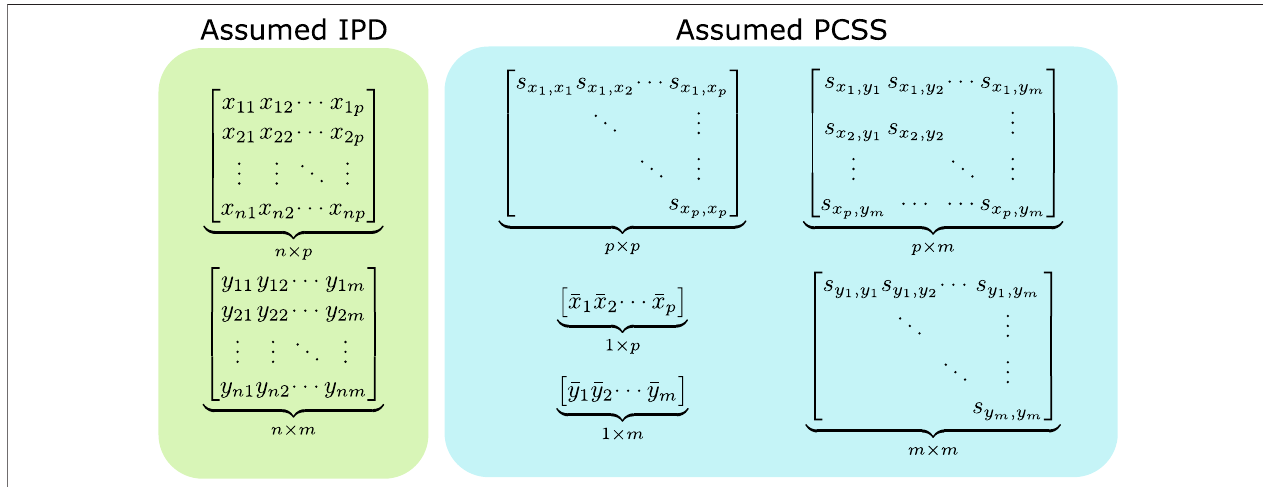
FIGURE 1 | Data assumed when modeling using individual participant data (IPD) and when using pre-computed summary statistics (PCSS) to model a product of m phenotypes( y 1 , ... , y m )asalinearfunctionof p covariates( x 1 , ... , x m ).WhilemodelingusingIPDrequires n × ( p + m )pointsofdata,usingPCSSonlyrequires p 2 + pm + m 2 + p + m values, which is far less when n is moderately large compared to p and m . All of these PCSS are readily available in existing PCSS repositories, or can be derived or approximated from other